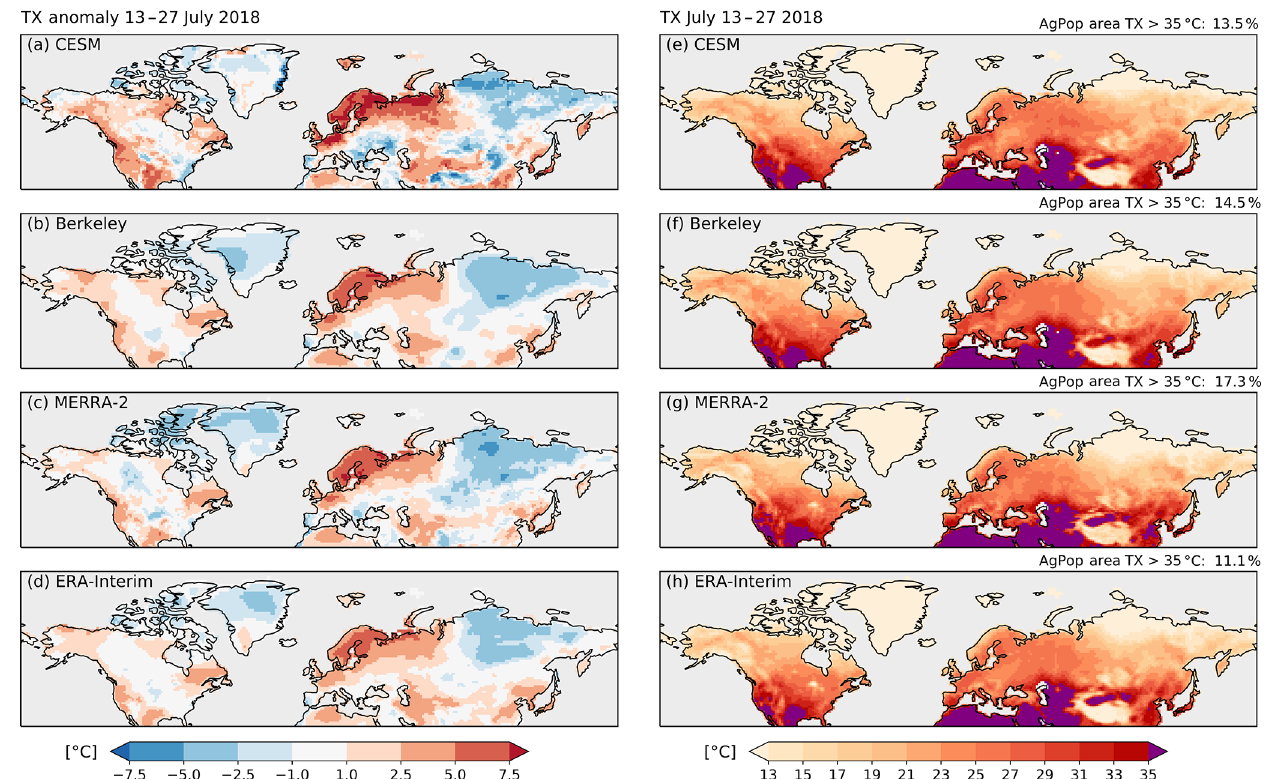
Figure A3. Maximum daily temperature (TX) and anomalies of TX averaged over 13–27 July 2018. (a) TX anomalies are shown with respect to the 1981–2010 climatology for the historical simulations; (b) same for ERA-Interim; (c) MERRA-2; and (d) Berkeley. (e) Absolute TX values for CESM are bias-corrected using quantile mapping and Berkeley Earth as a reference to calibrate the correction. (f) Absolute TX values from Berkeley; (g) MERRA-2; and (h) ERA-Interim are shown as comparison. In the right corner above (e–h) the percentage of the AgPop region where TX averaged over 13–27 July 2018 exceeds 35 ◦ C is